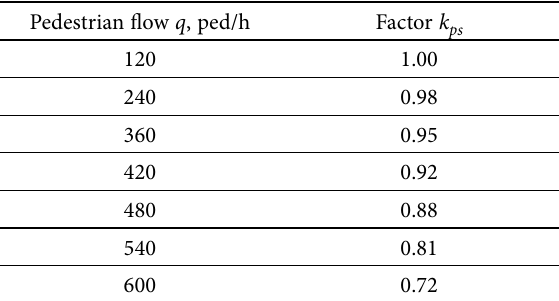
Table 2. Factor for assessing pedestrian traffic impact Pedestrian flow q , ped/h